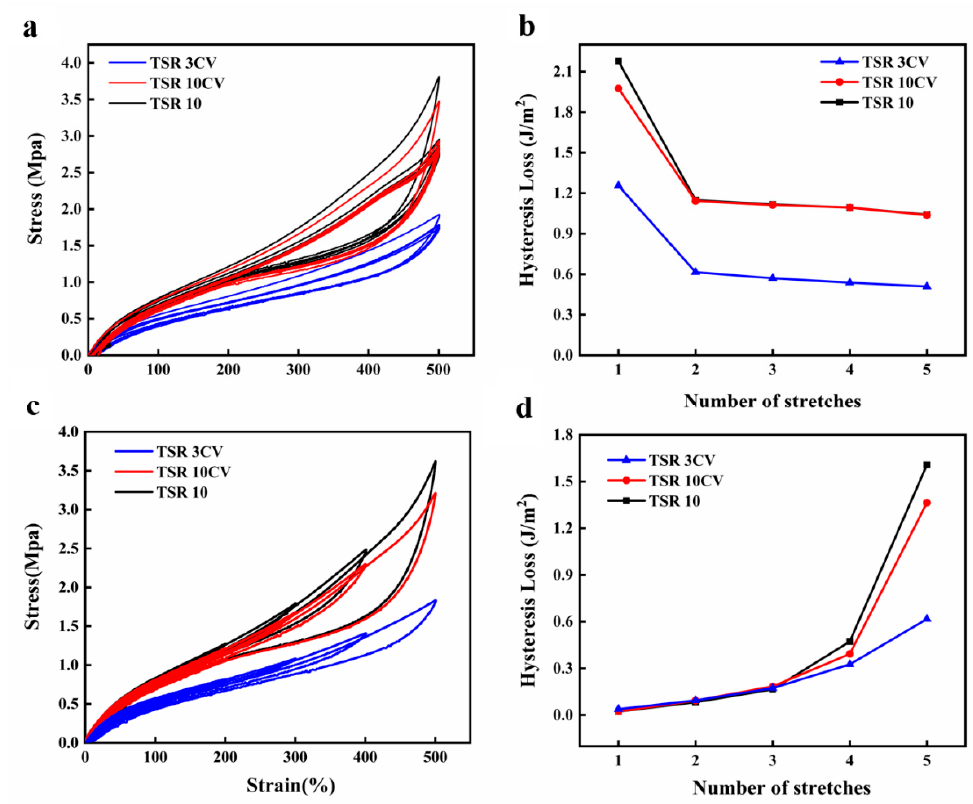
Figure 5. Energy dissipation of NR vulcanizates during tensile cycle progress. ( a ) Cyclic hysteresis curves of NR vulcanizates at 500% fixed strain; ( b ) Hysteresis loss of NR vulcanizates progress at 500% fixed strain; ( c ) Cyclic hysteresis curves of NR vulcanizates at different strain; ( d ) Hysteresis loss of NR vulcanizates progress at different strain.